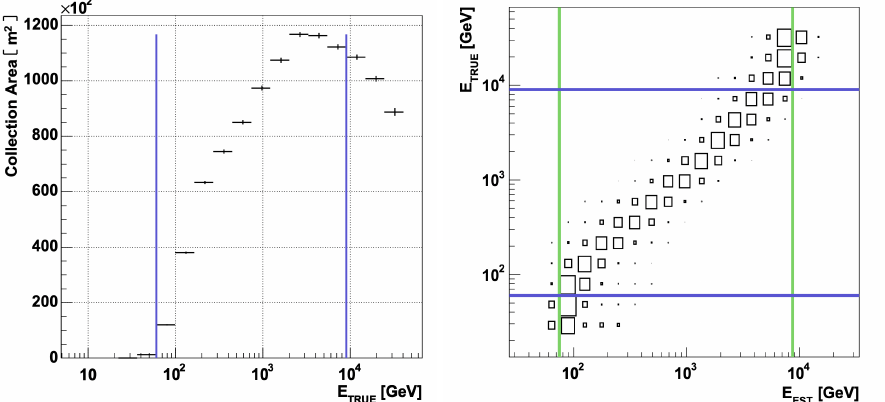
Figure 10. Left panel : Evolution in energy of the collection efficiency ε ( E ) multiplied by the collection area of the telescope, which for IACTs is generally of the order of 10 5 m 2 . Right panel : evolution in reconstructed/estimated energy and true energy of the binned dispersion energy (or migration matrix). Both figures are Reprinted with permission from Ref. [67] Copyright 2007 Albert et